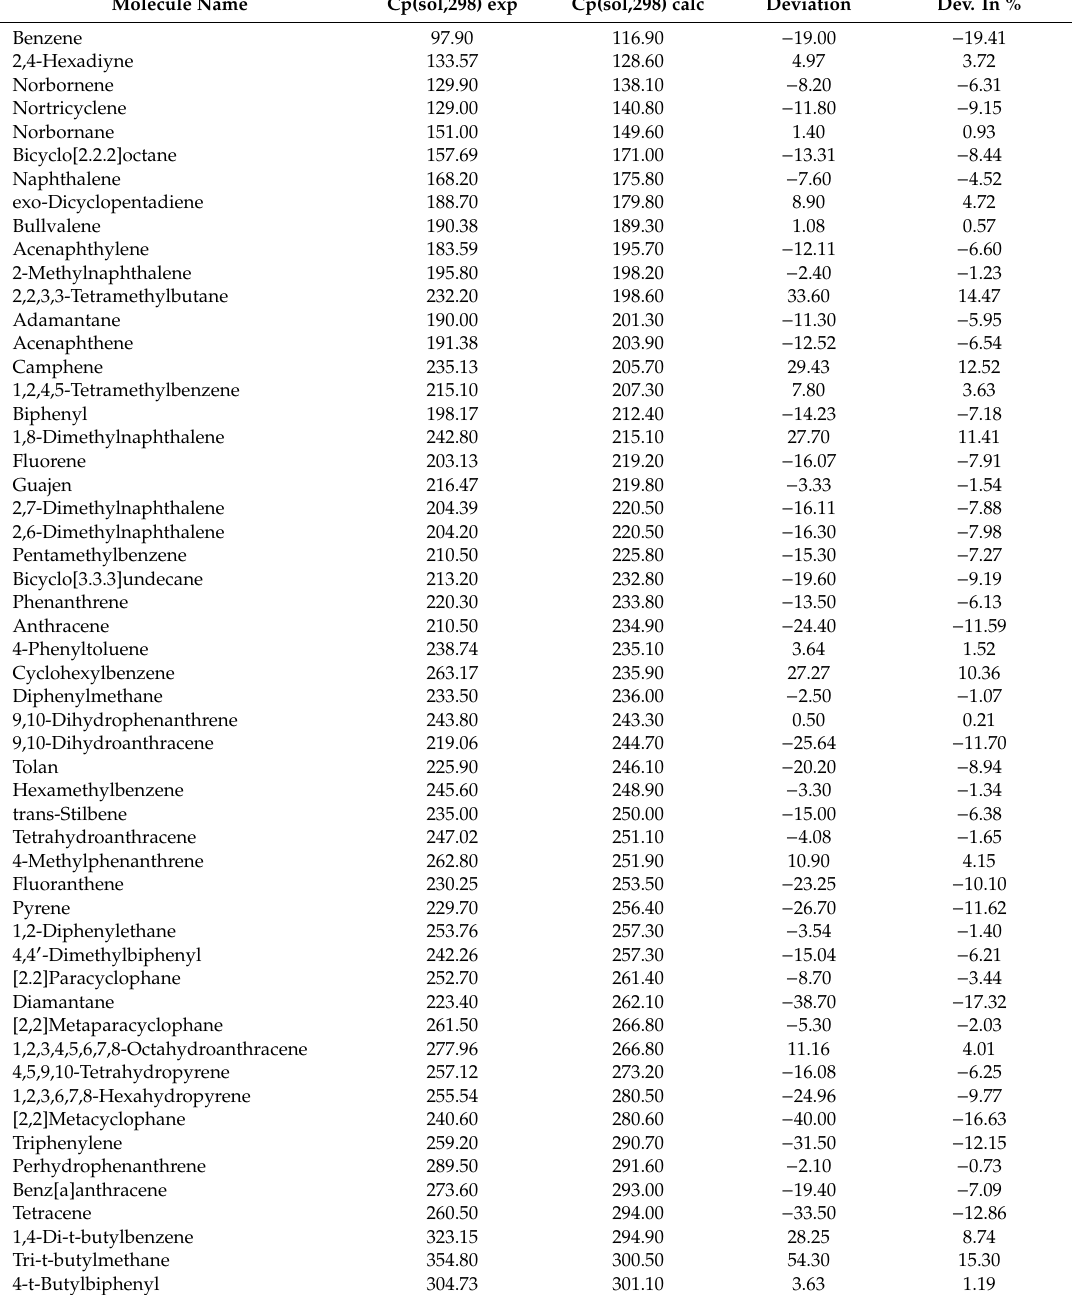
Table 13. Experimental and Equation (5)-calculated Cp(sol.298) of 107 hydrocarbons in J / mol /